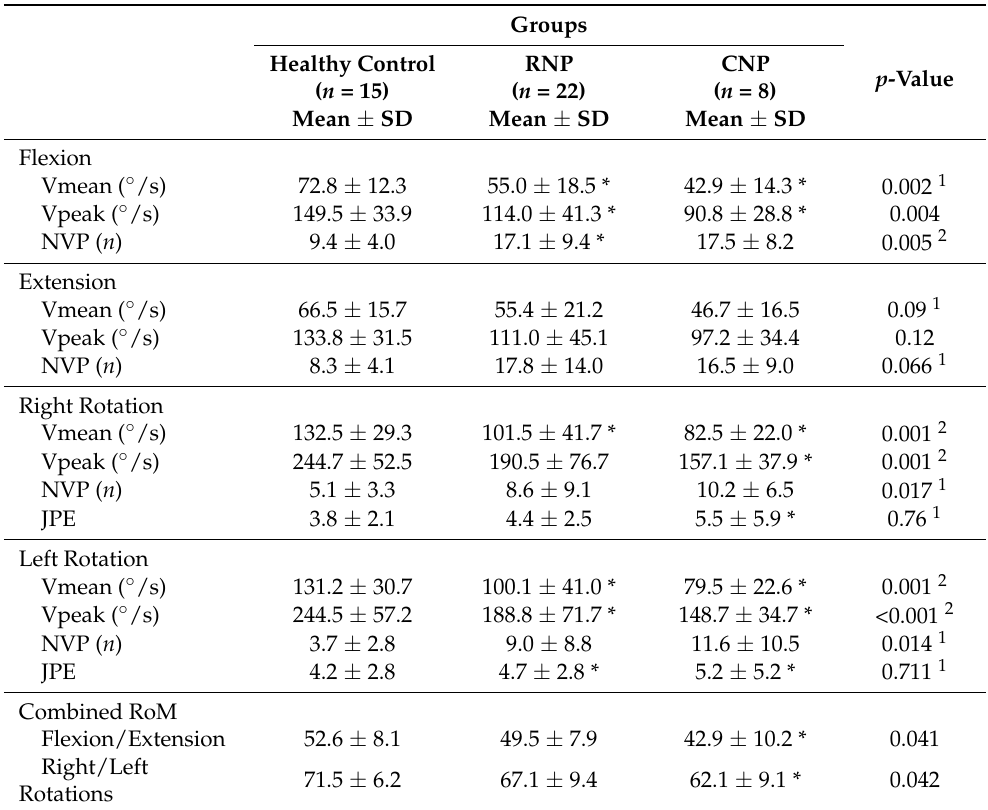
Table 3. Summary statistics for the kinematic and proprioception features of all three groups with differences assessed using One-way